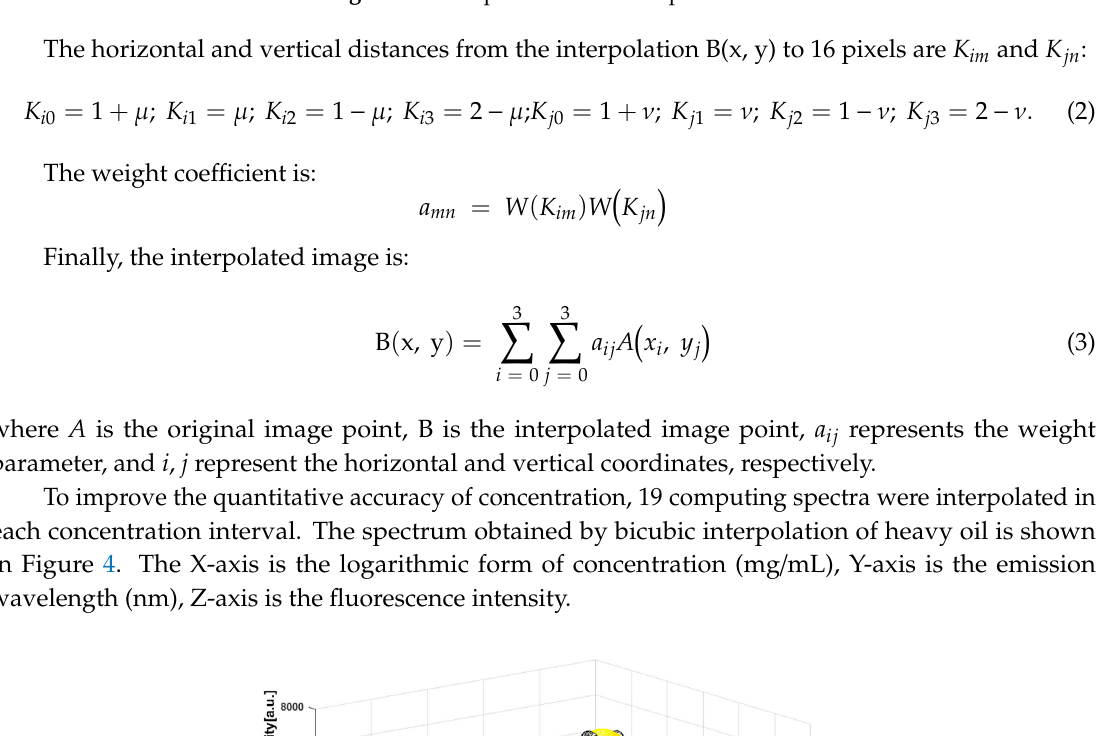
Figure 3. Principle of bicubic interpolation.